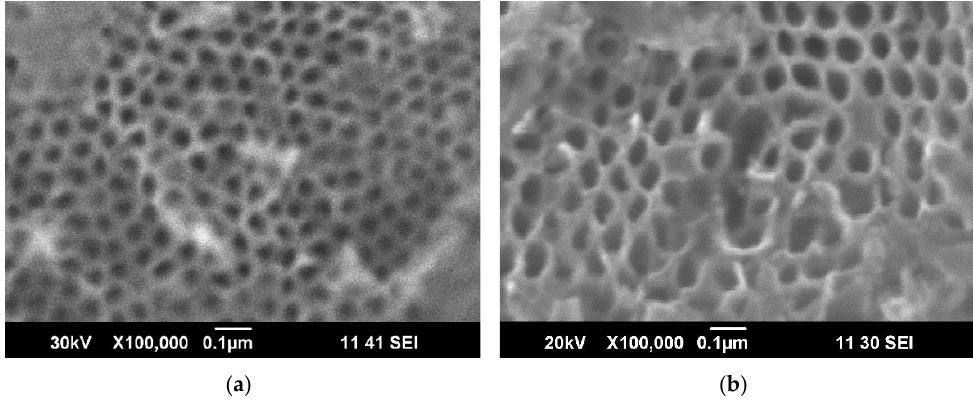
Figure 1. Scanning electron microscopy (SEM) images of ( a ) ID-0.1/1-NTO and ( b ) AD-0.10-NTO.